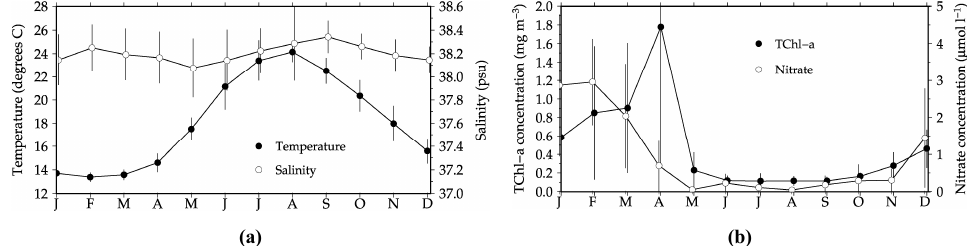
Figure 4. (a) Average seasonal cycles of sea-surface temperature (black symbols) and sea-surface salinity (open symbols) at BOUSSOLE (depth < 10 m), from the buoy data collected from 2003 to 2019. (b) Average seasonal cycles of sea-surface [TChl -a ] (black symbols) and nitrate concentrations (open symbols). Vertical bars are standard deviations of the displayed monthly means (slightly shifted between the two parameters for clarity).